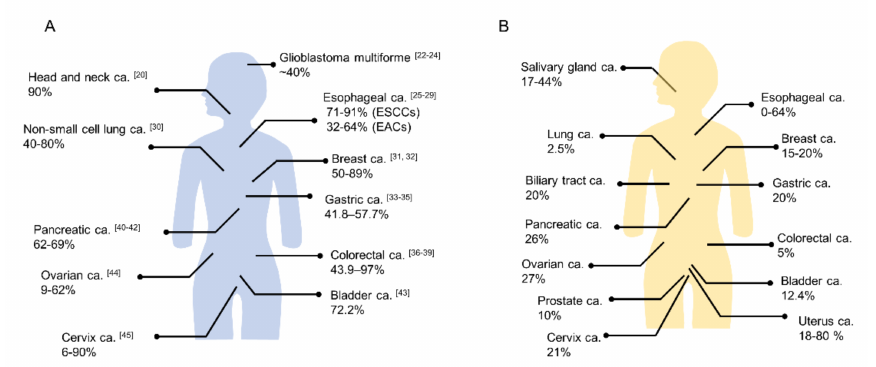
Figure 2. The positivity proportion of ( A ) EGFR and ( B ) HER2 expressions in various cancers (ca.; carcinoma, ESCC; esophageal squamous cell carcinoma, EAC; esophageal adenocarcinoma). (( A ) The numbers in the brackets show reference number. ( B ) Quoted from references